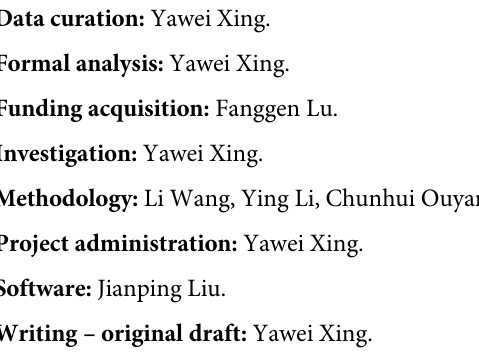
S1 Table. Raw data summary. S2 Table. Alpha diversity. Specific alpha diversity values of the gallbladder samples. S3 Table. Bacterial genera of the gallbladder. The relative abundance of bacterial genera of the gallbladder in rabbits before and after weaning at the genus level. S4 Table. Bacterial genera of the gallbladder and feces. The relative abundance of bacterial genera of the gallbladder and feces in rabbits after weaning at genus